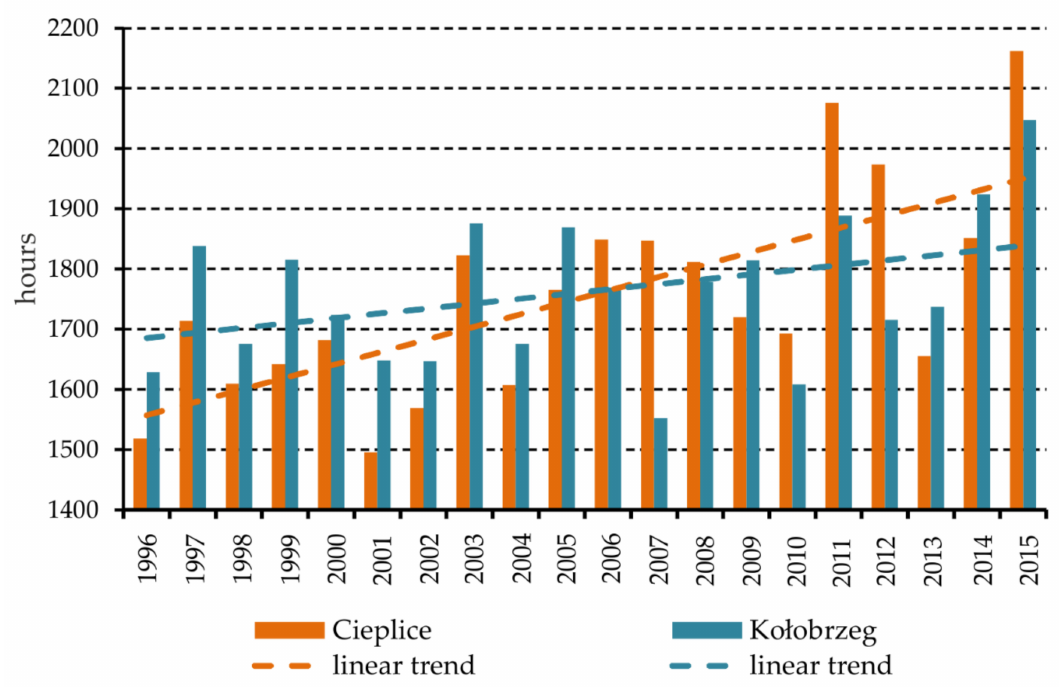
Figure 2. Annual sums of actual sunshine duration in Cieplice and Kołobrzeg in the years